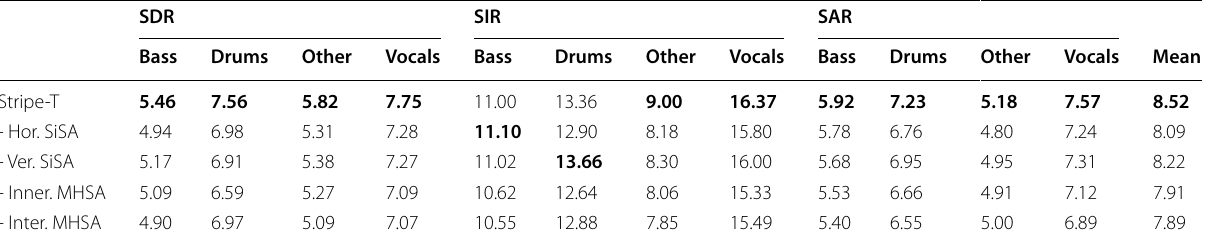
The best metrics are highlighted using bold font